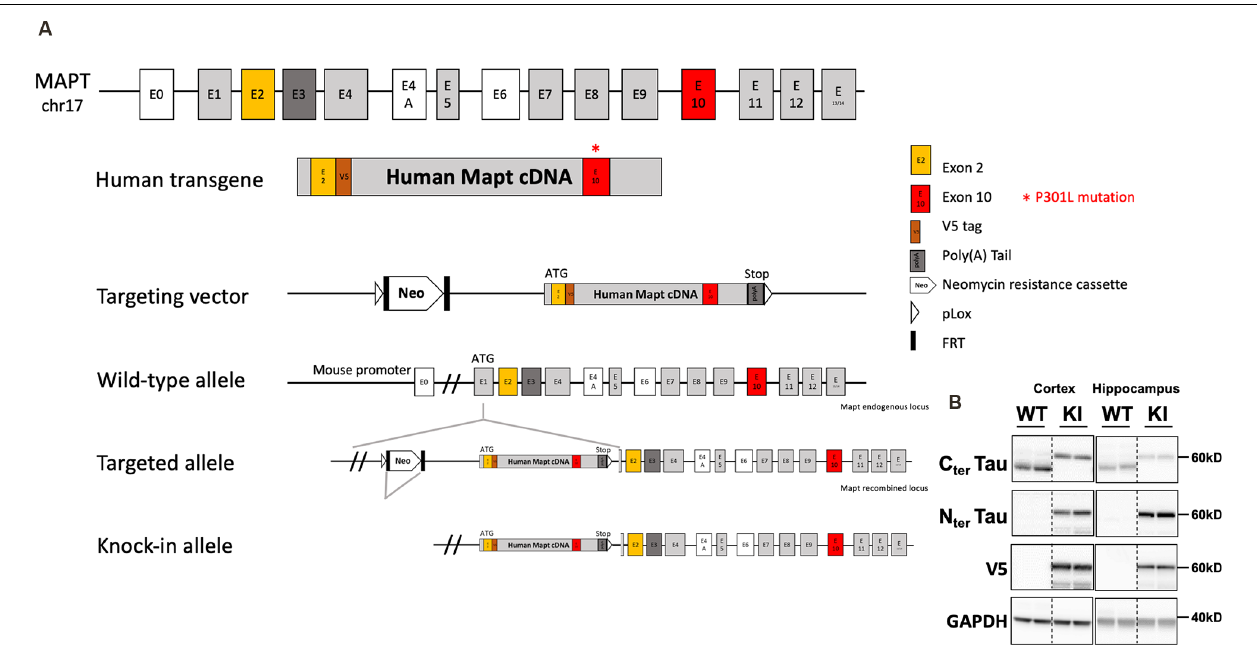
FIGURE 1 | Generation and tau expression in the tau knock-in mouse model. (A) Generation strategy of tau knock-in (KI) mice. MAPT human transgene is composed of 10 exonic regions with P301L mutation on exon 10. A V5 epitope tag is inserted after exon 2. STOP codon is inserted followed by exogenous poly(A) Tail. The transgene is under the control of the Mapt mouse endogenous promoter. Insertion of the targeting vector was mediated by cre-loxP recombination (pLox sites shown as empty arrows). A floxed neomycin resistance (Neor) cassette used for positive selection was removed from the targeted allele by FRT (FRT sites shown as black rectangles) recombination sites. Positions and sizes of exons and introns are not to scale. (B) Representative expression of tau and V5 in the cortex and hippocampus of tau KI mice and WT littermates (two showed mice out of